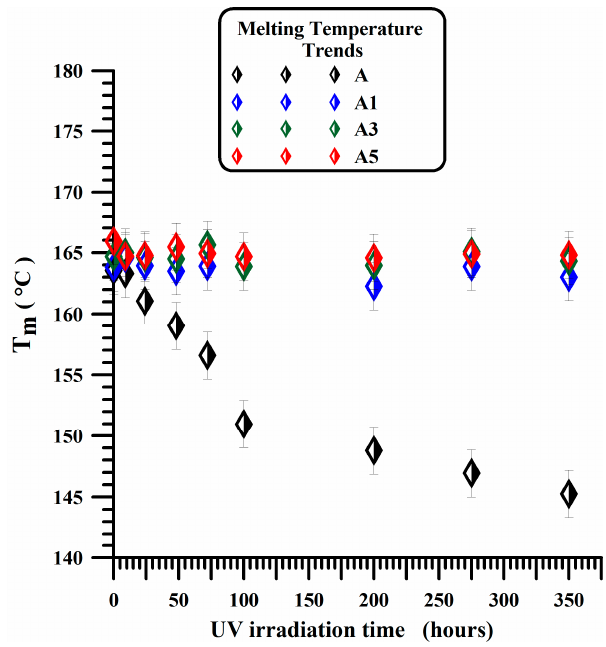
Figure 9. Melting temperature vs UV irradiation times of iPP sample (A) and photooxidated nanocomposites (A1, A3, A5).